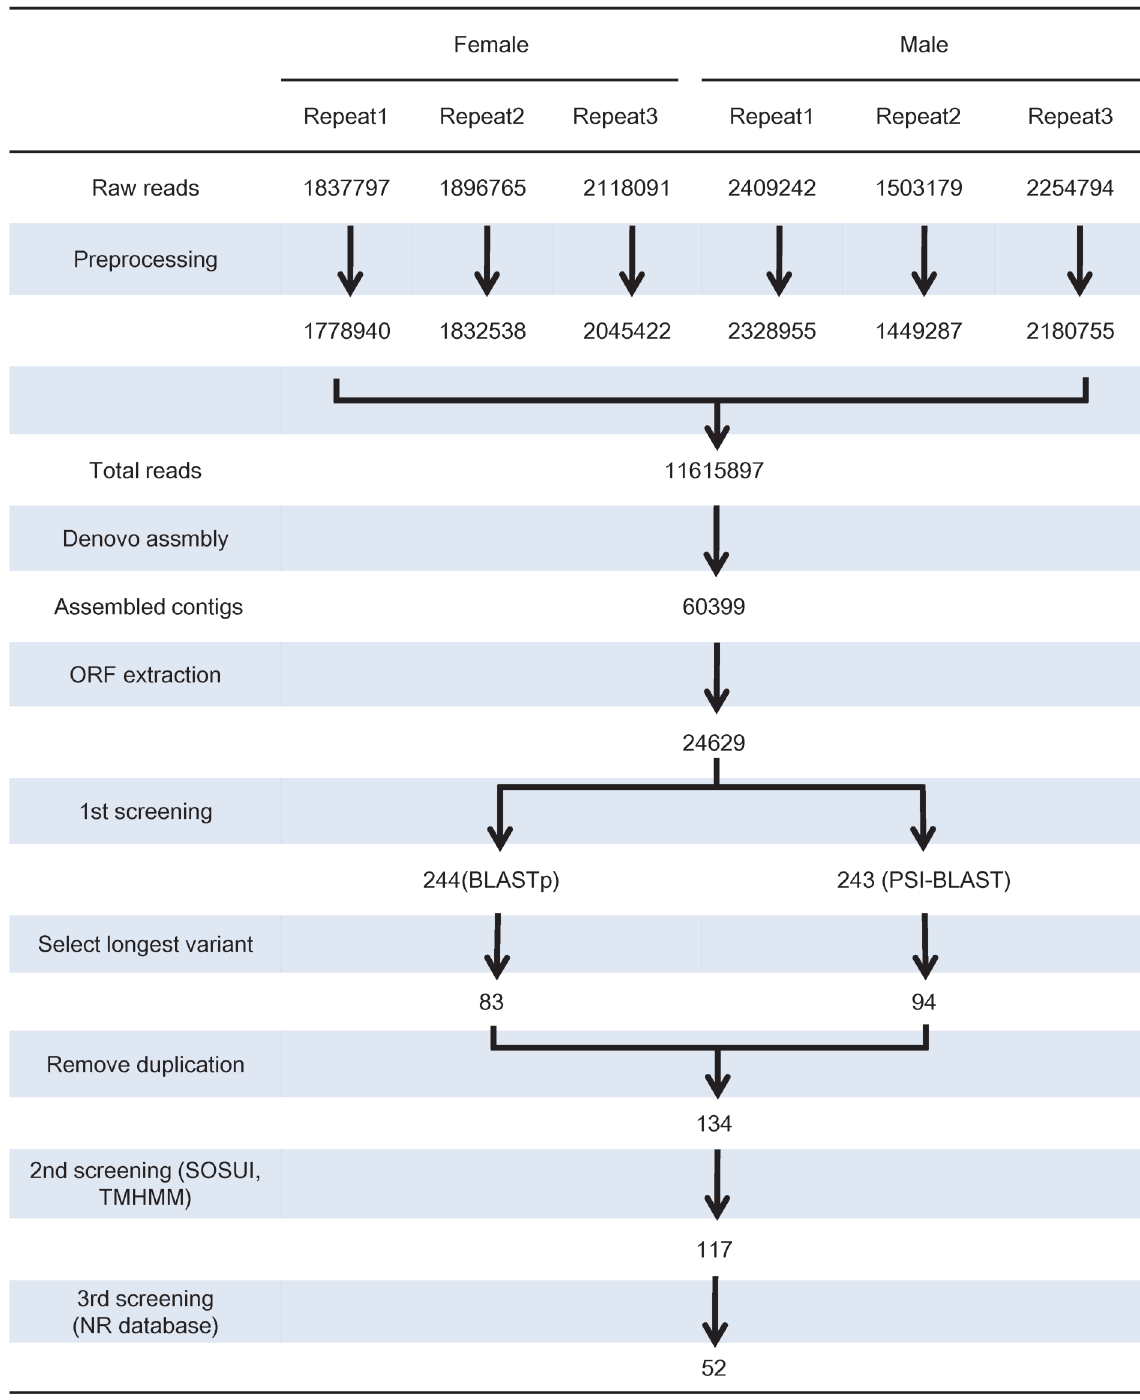
Fig 1. Schematic diagram of sequence data analysis for odorant receptors. The numbers of reads or contigs at each step are indicated. See text for detailed explanation.